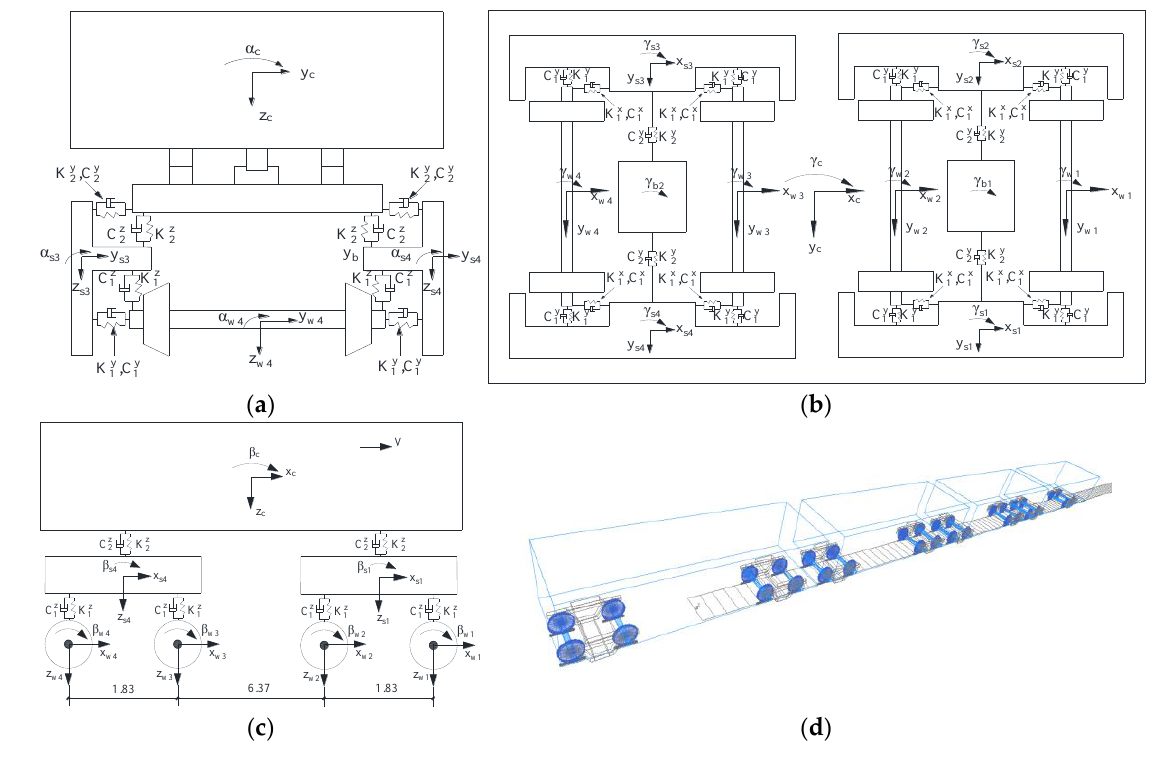
Figure 14. The vibration model of heavy-haul vehicle: ( a ) Front view of a vehicle; ( b ) Top view of a vehicle; ( c ) Side view of a vehicle (unit: m); ( d ) The finite element model of the heavy-haul train.